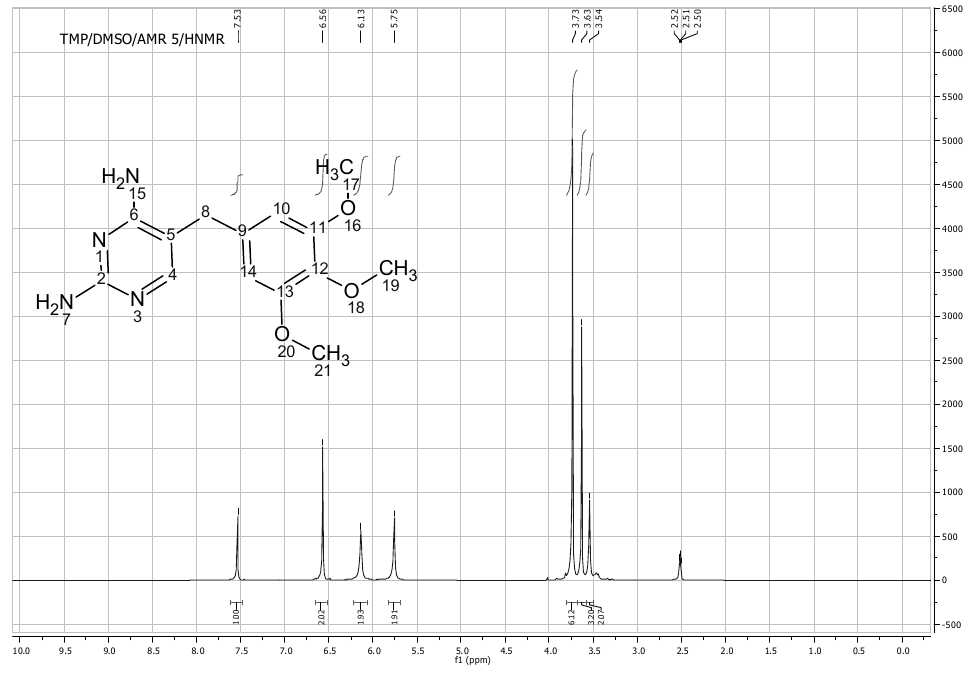
Figure 8. 1 HNMR spectra of trimethoprim free base solubilized in DMSO.